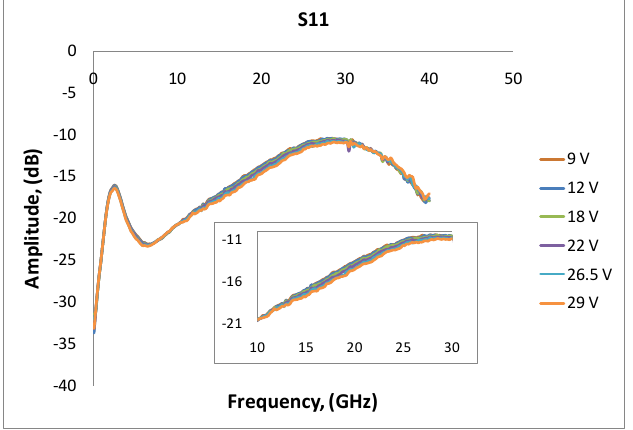
Figure 6. Measurements of reflection coefficient S11 for different applied voltages into the heaters.